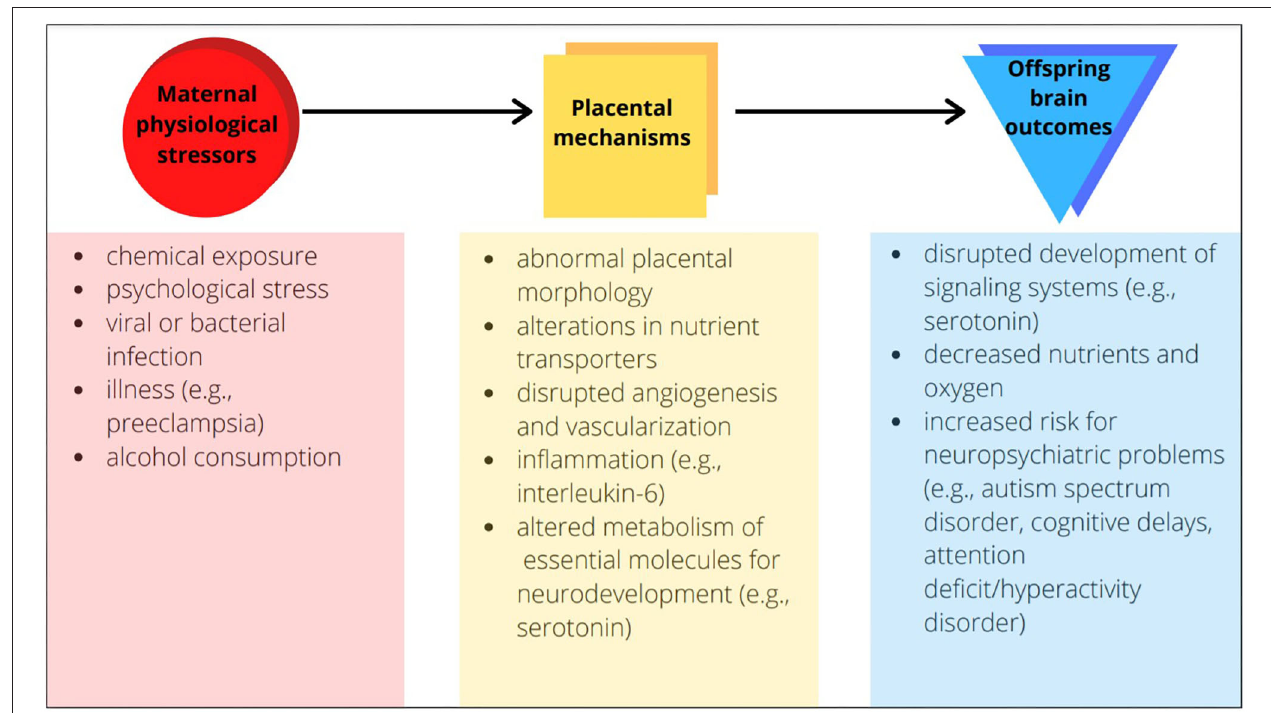
FIGURE 1 | Examples of placental mechanisms as the link between maternal physiological stressors and offspring brain